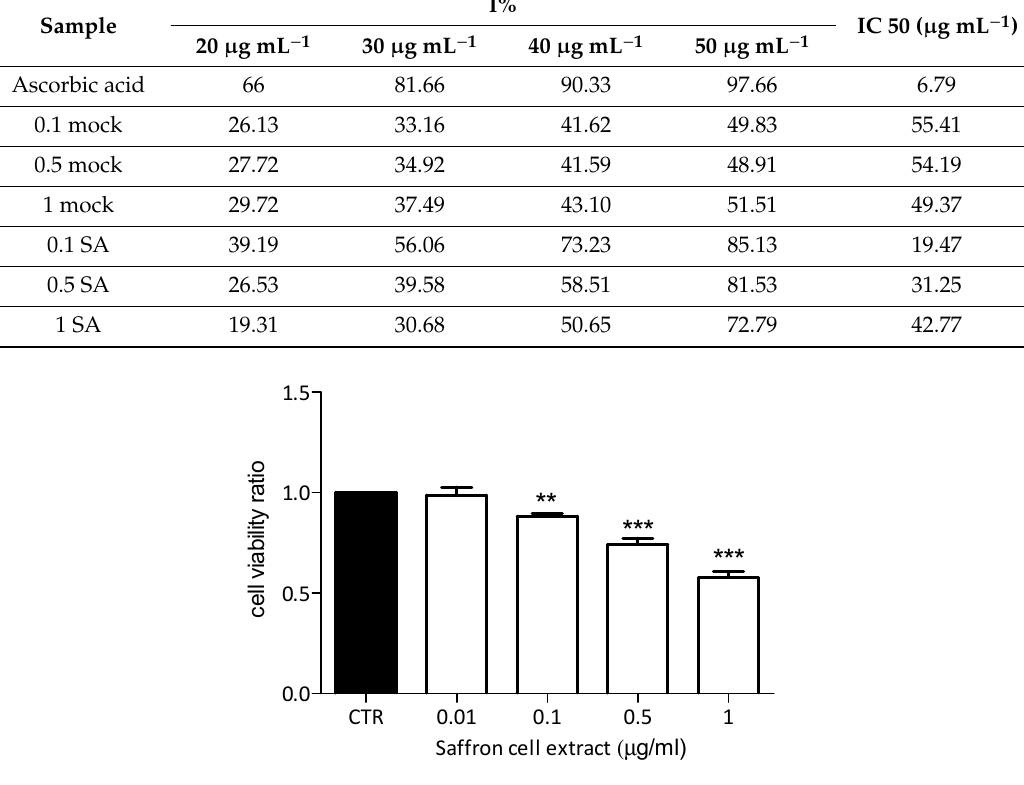
Figure 8. Cell viability of human breast cancer cell line MDA-MB-231 after 72 h treatment with sa ff ron aqueous extracts at di ff erent concentrations. Data represent mean values of independent experiments performed in six technical replicates, ± standard deviation. CTR, control. ANOVA statistic test followed by Dunnett’s post-test was used to compare each treatment with the control (** p < 0.01 and *** p <